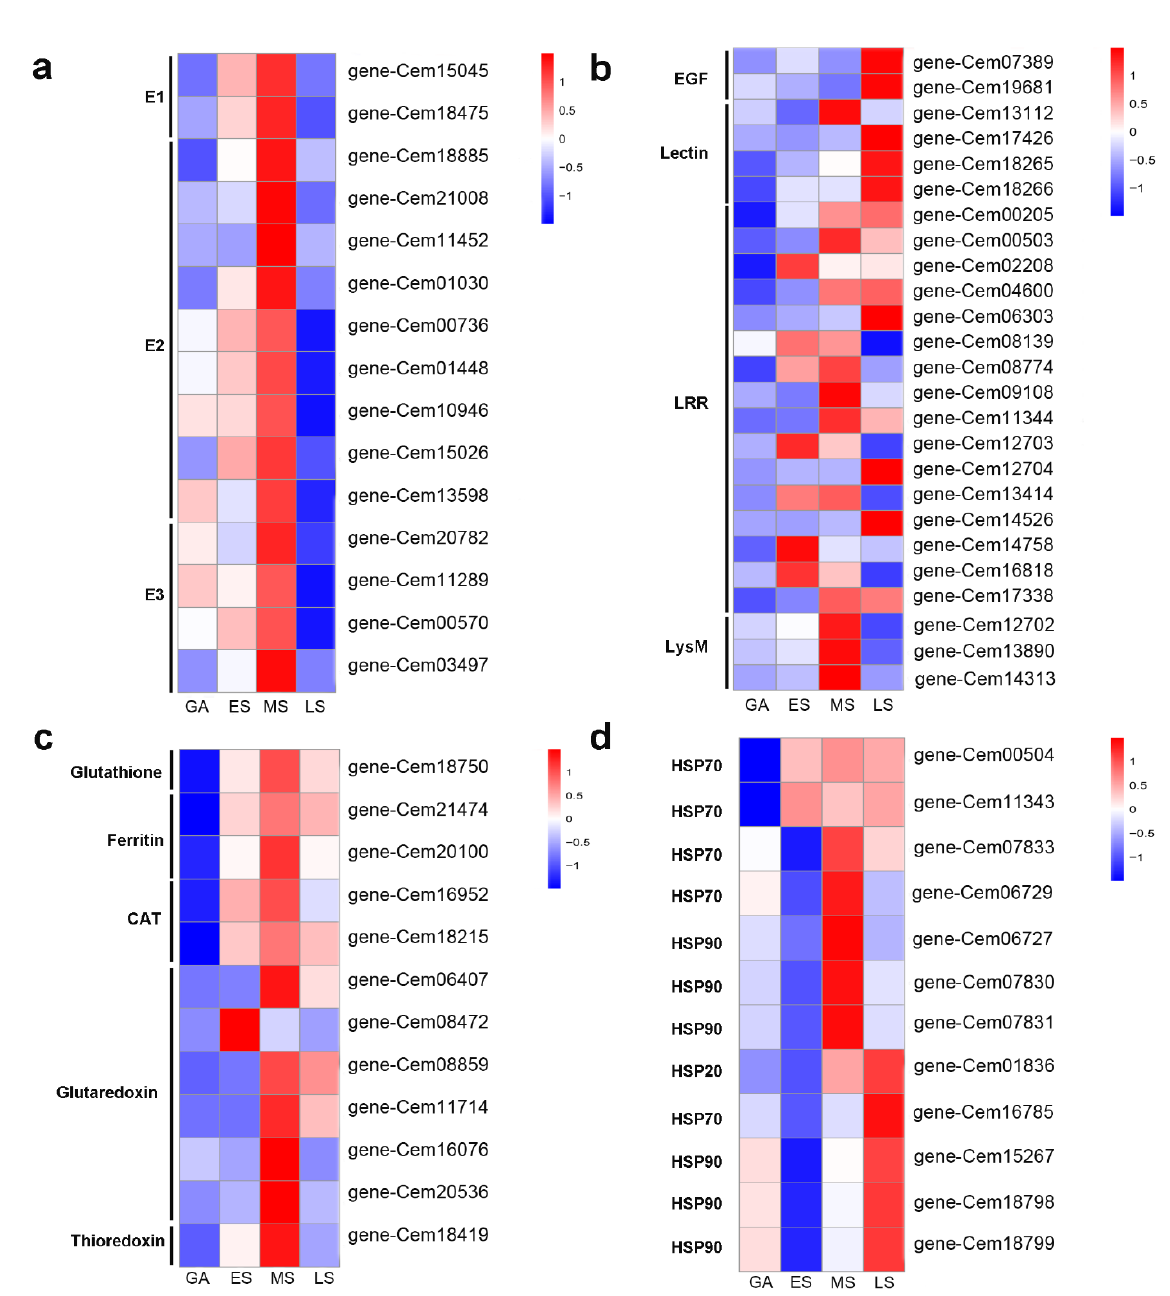
Figure 4. Heatmap of defense-related genes in G. emersonii during infection. ( a ) Ubiquitin – proteasome system (UPS)-related genes; ( b ) typical pattern-recognition receptor (PRR)-related genes; ( c) ROS-related genes; ( d ) heat shock proteins (HSPs)-related genes.